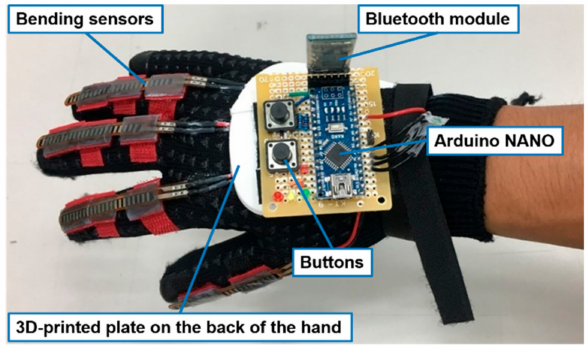
Figure 9. Implemented hand-sensing